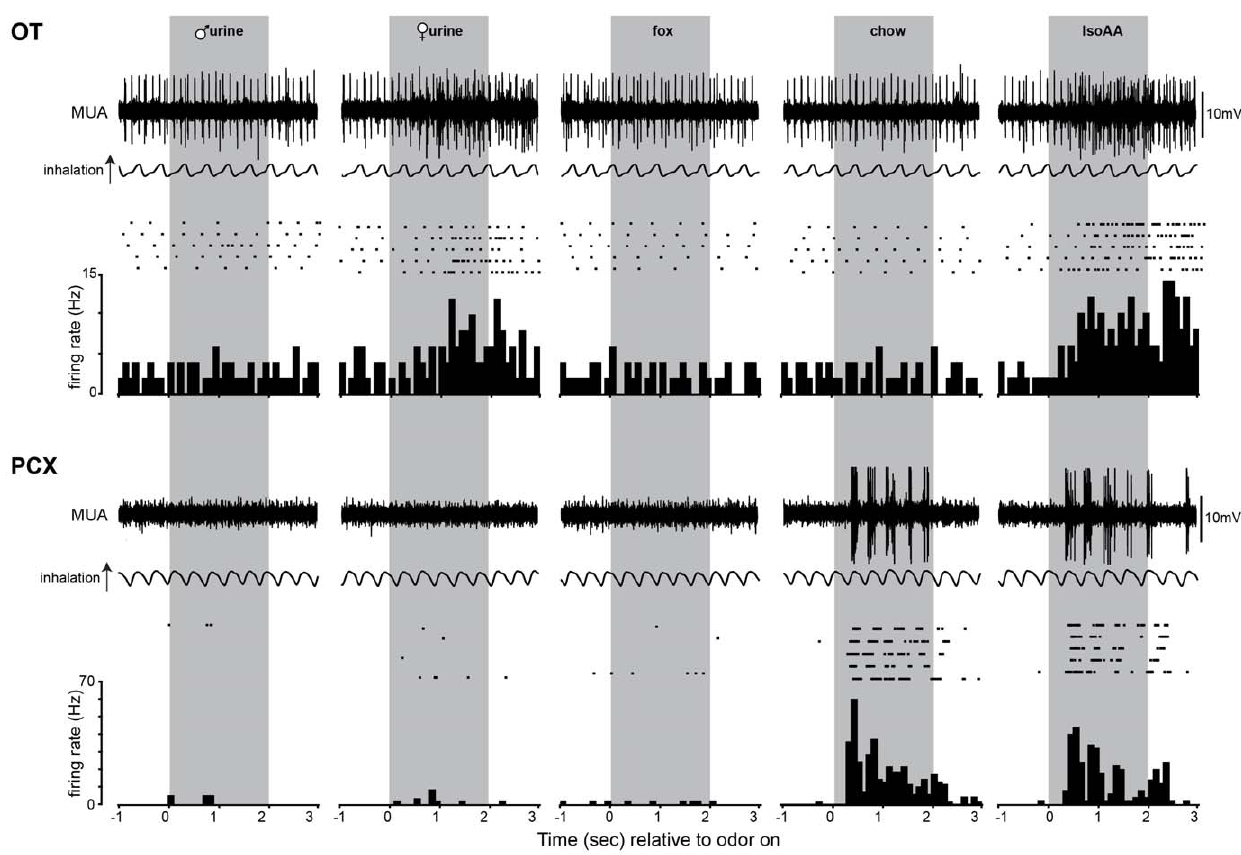
Figure 3. Example OT and PCX odor-evoked spike trains and stimulus histograms. Multiunit activity (MUA) from a single OT (top) and PCX (bottom) recording. Also shown in raster and peristimulus time histogram (PSTH) form is the activity of a single isolated unit (1 unit/region) across each trial of odor presentation. For these purposes, we selected a spontaneously active OT example which is representative of the greater spontaneous firing among OT units versus those found in the PCX (Fig. 2). In this example, the PCX unit burst more phasic with respiration, though this is not consistent across all units. Units from both structures in these examples responded to 2 of the 5 odors.